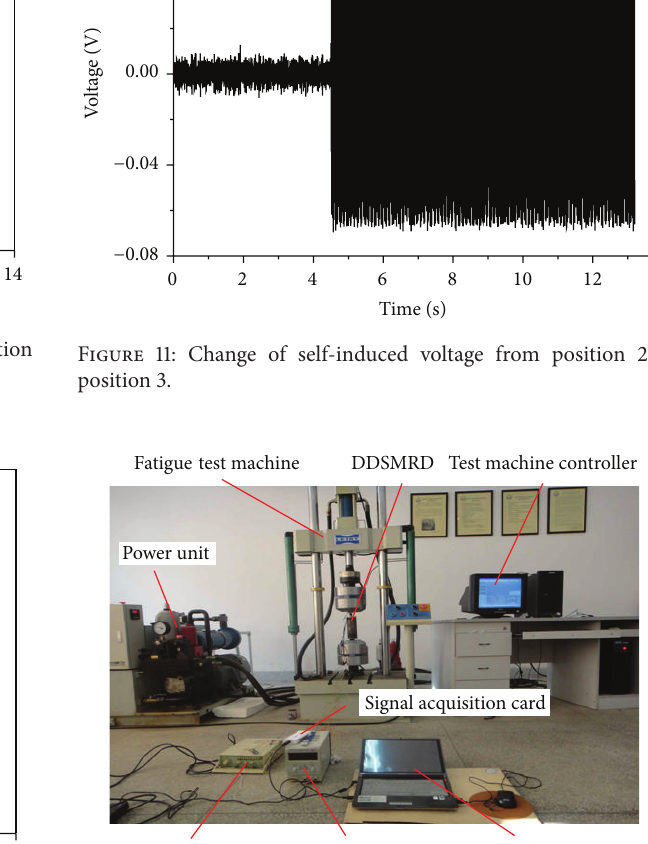
Figure 12: Test rig of dynamic displacement self-induced perfor-